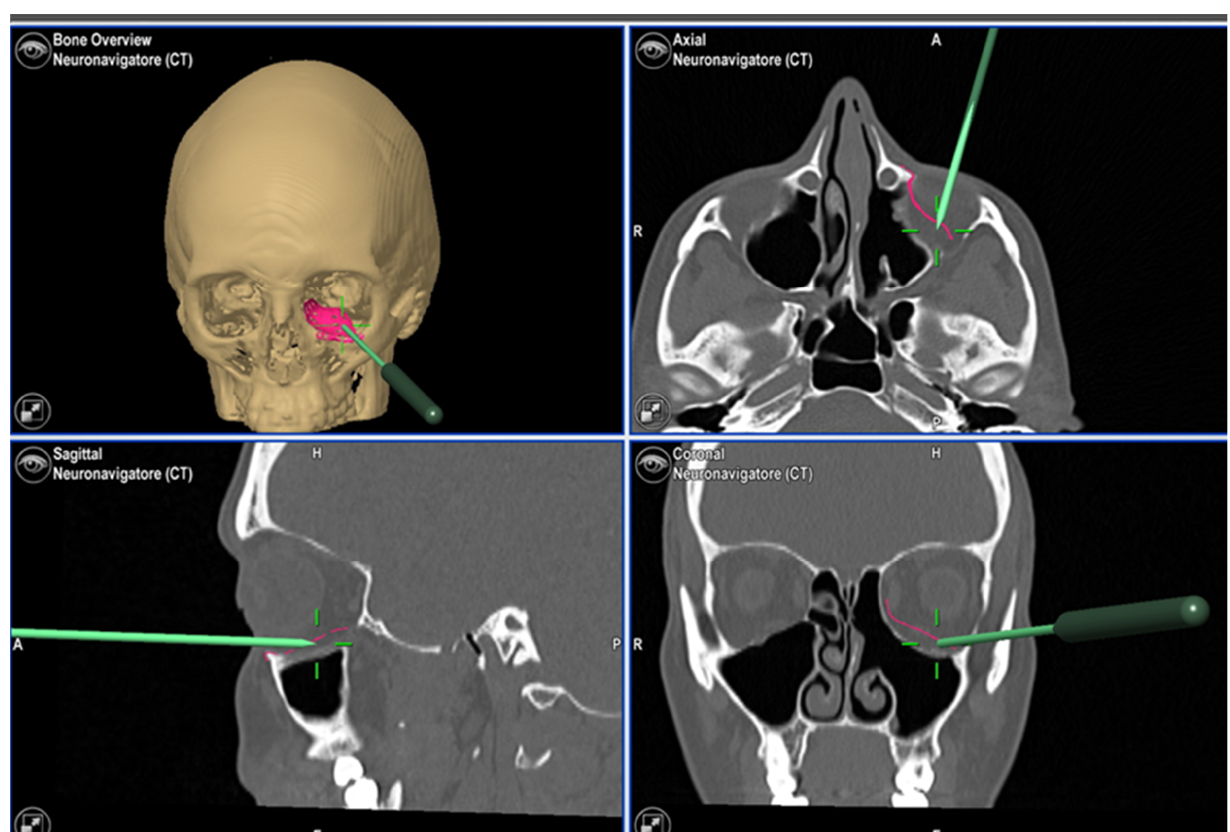
Figure 5. Screenshot obtained during intraoperative PSI navigation.